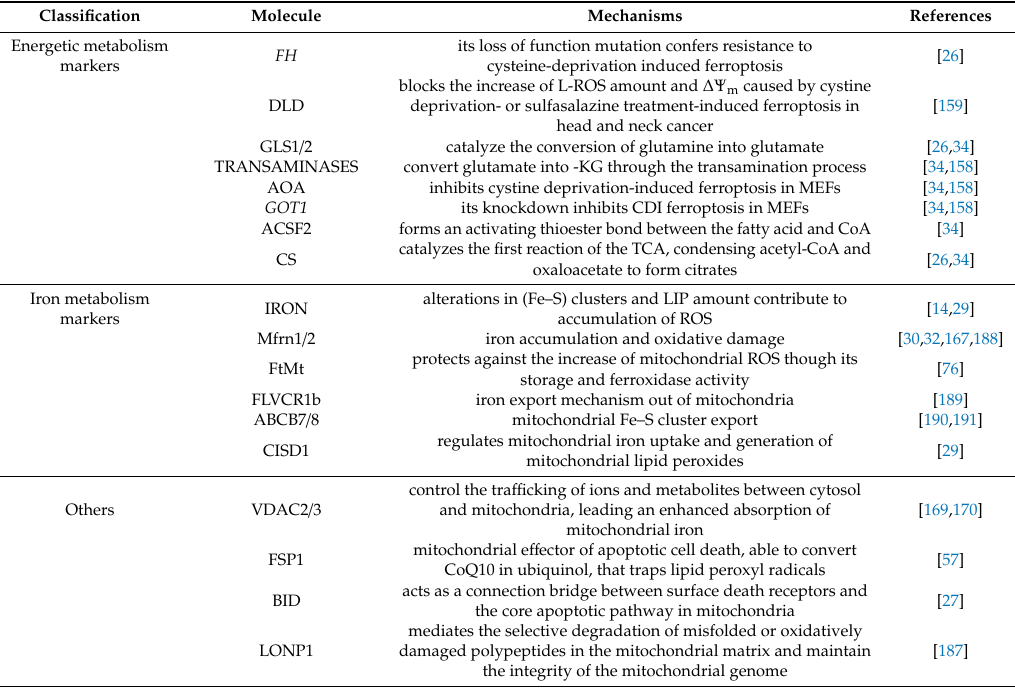
Table 4. Mitochondrial markers of